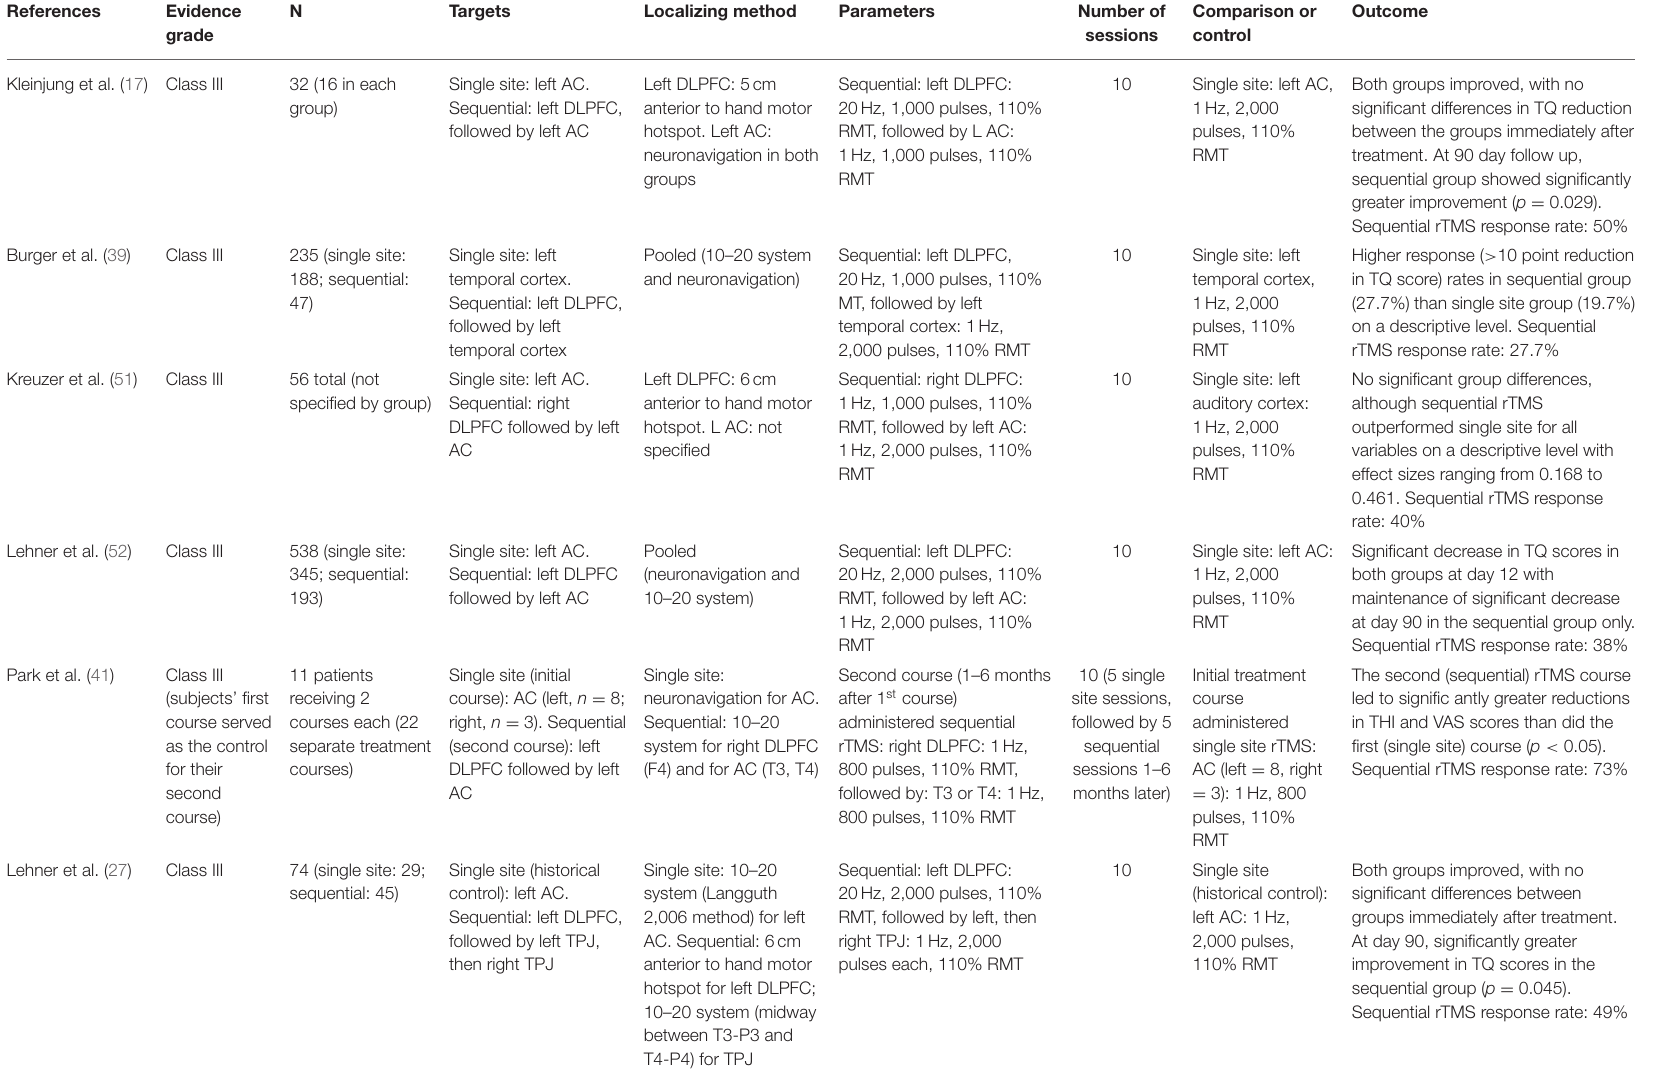
TABLE 3 | Sequential prefrontal and temporo-parietal rTMS approaches in the treatment of